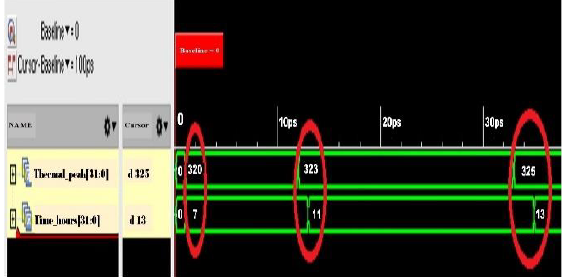
Fig. 6 . Results of the thermal simulation with Nclaunch